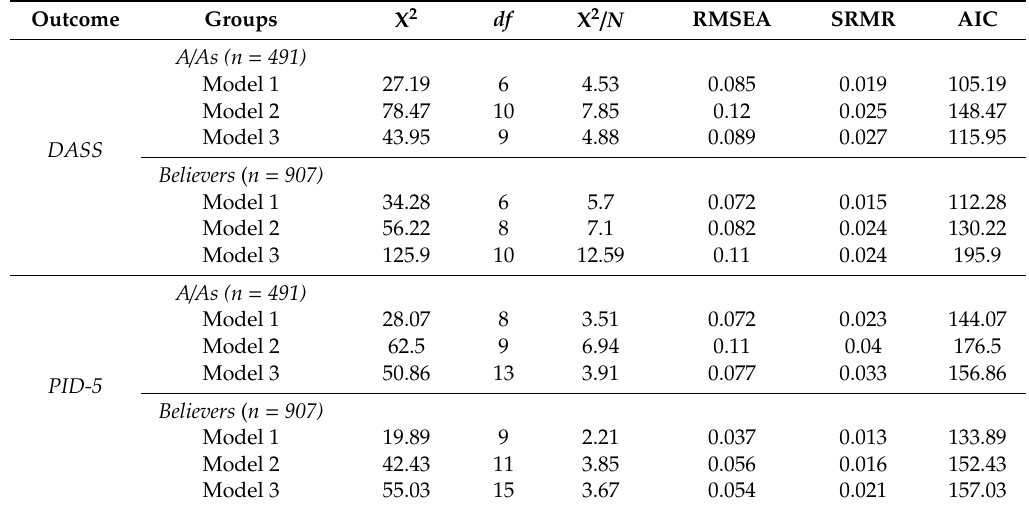
Table 6. Results of SEM Analyses for Three Causal Models Comparing Atheists / Agnostics and Believers on Measures of Emotional and Characterological